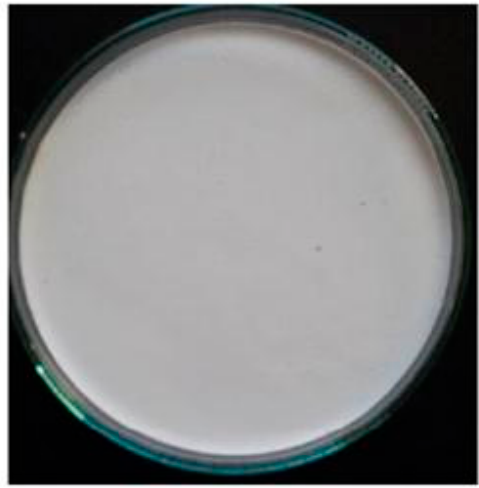
Figure 2. Photograph of the coating of sample WF-5.